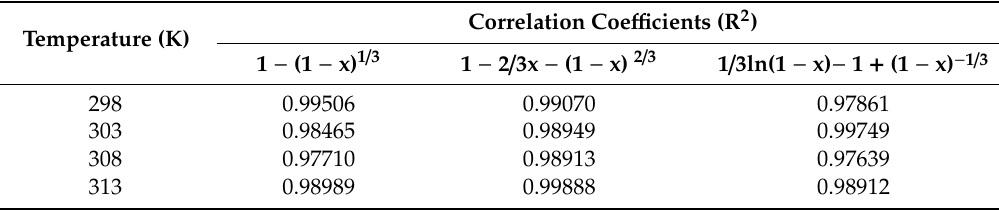
Table 3. Correlation coe ffi cient of di ff usion control and interface chemical reaction control at di ff erent temperatures under ultrasonic